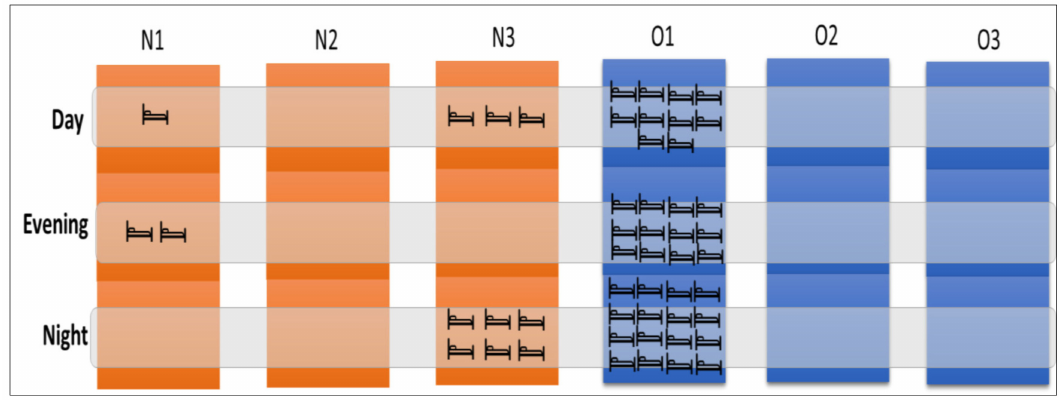
Figure 8. The configuration of flexible